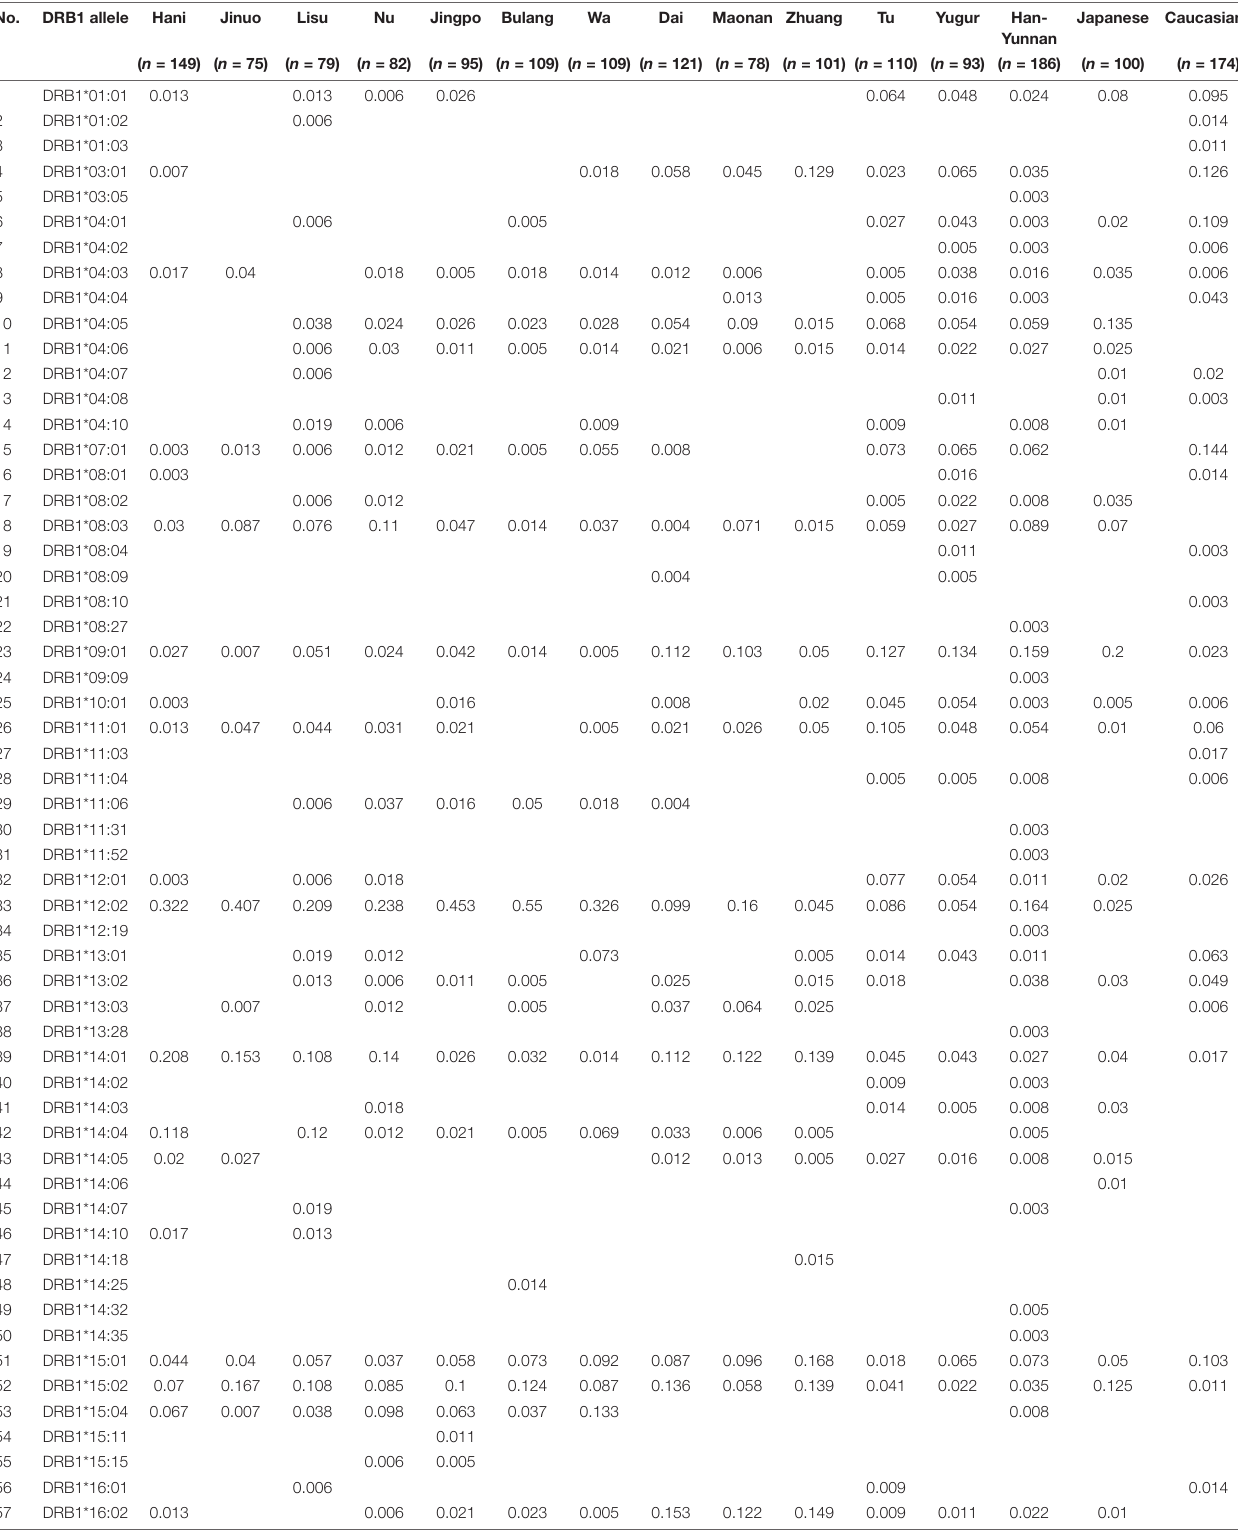
TABLE 2 | HLA-DRB1 allele frequencies in 15